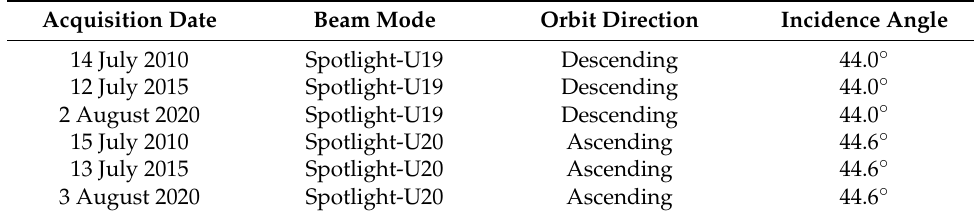
Table 1. RADARSAT-2 data acquisition parameters.